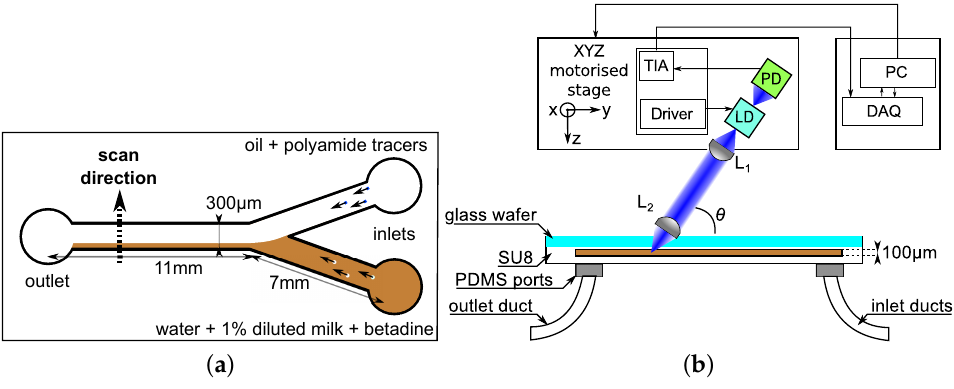
Figure 1. Experimental setup description. ( a ) Physical description of the Y-shaped microreactor ( top view). The figure describe the location of the two fluids with the respective tracers; and ( b ) optical arrangement and sensor architecture ( lateral view). The laser (LD) light is focused on the channel using a collimation lens (L1) and a focusing lens (L2) optical arrangement. Oil and water flows are fed through the inlets using two independent syringe